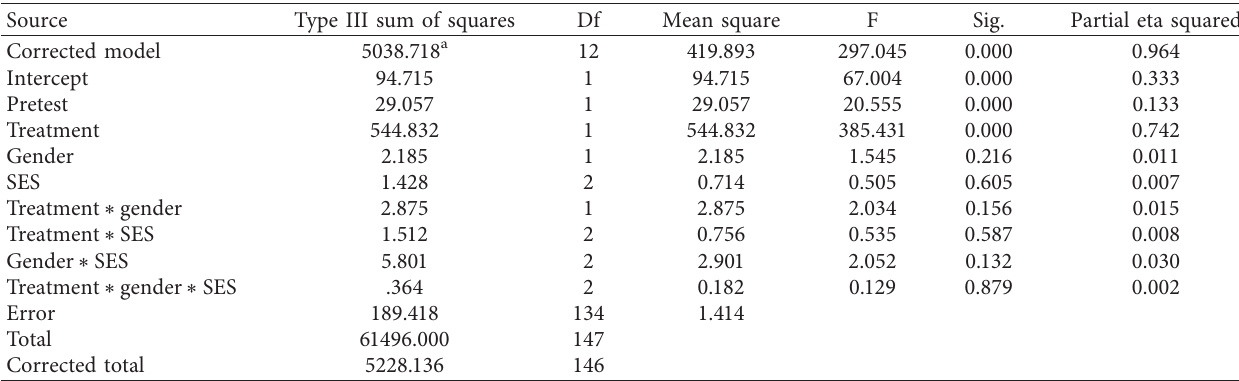
Table 5: Summary of analysis of covariance (ANCOVA) of retention test of students by treatments, gender, and SES.